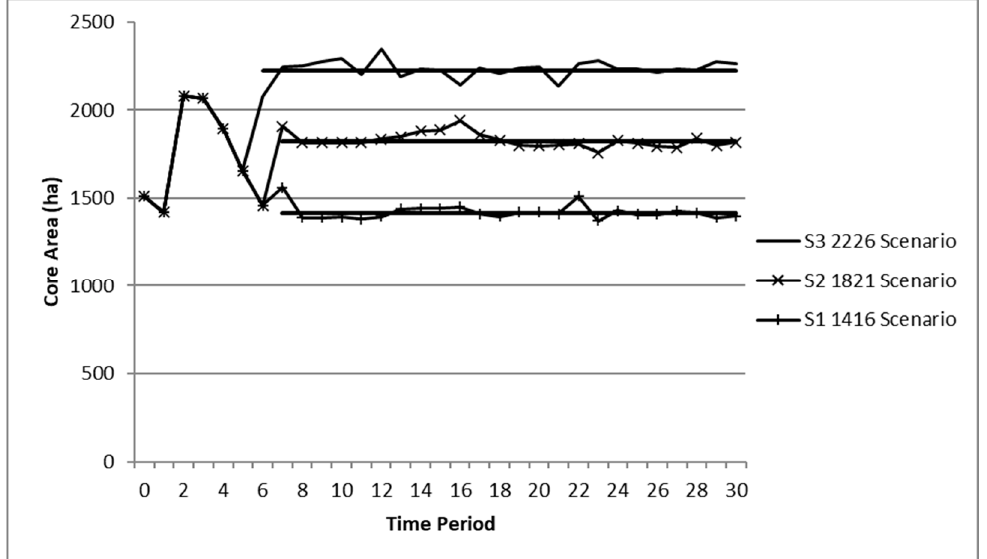
Figure 3. Core area constraint satisfaction for the three scenarios in this study. Horizontal lines are the core area constraint levels.